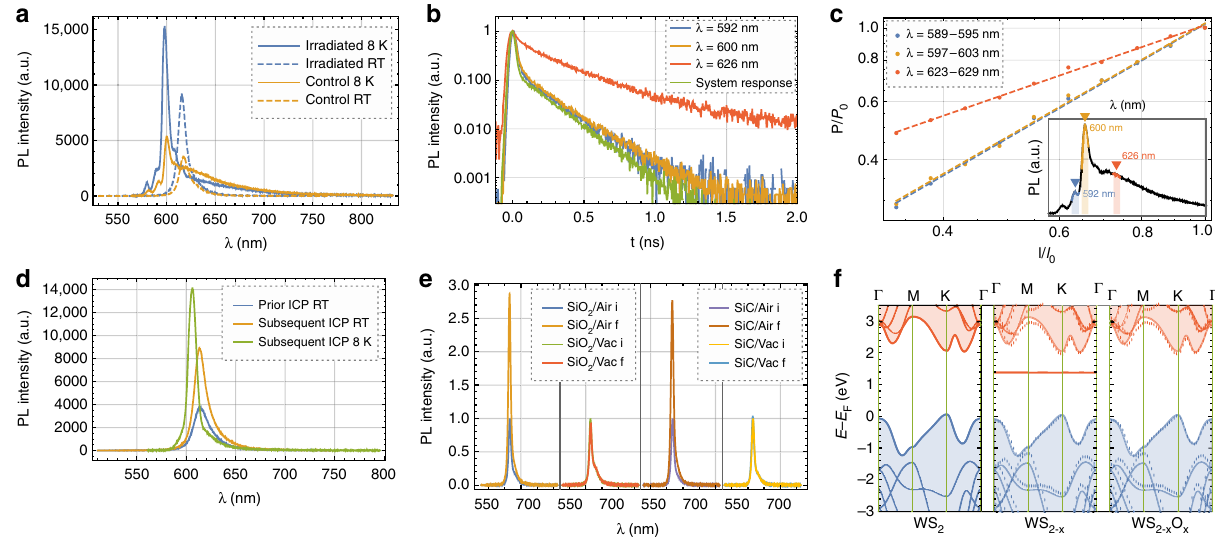
Fig. 5 Identi fi cation of the γ -ray induced healing mechanism. a Photoluminescence (PL) spectrum of γ -irradiated and control samples at 8 K and room temperature. The control sample shows strong defect emission in the red sideband. b Spectrally and time-resolved PL reveals carrier lifetimes close to the system response at λ = 592 and 600 nm and 361(3) ps at 626 nm, con fi rming excitonic and defect nature of the emission. Unlike for defects, the radiative lifetime for excitons/trions is proportional to temperature. The spectral positions at which the lifetimes were measured are marked with correspondingly colored triangles in c (small inset). c Spectrally resolved power dependence on a log-log plot reveals a slope close to 1 at λ = 592 and 600 nm, indicating excitonic emission, while the slope <1 at 626 nm means the emission originates from defects. The inset shows the positions in the spectrum (marked with the corresponding colors) at which the power dependence is measured. d PL emission prior and subsequent to the inductively coupled plasma treatment shows a similar increase in PL brightness compared to the γ -irradiated samples. In addition, at low temperature no defect emission becomes visible, con fi rming that oxygen can passivate vacancies. e Repetition of the γ -irradiation on SiO 2 and SiC substrates as well as in air and vacuum show that the atmosphere must be the source of oxygen used for the defect healing, most likely through adsorbed oxygen onto the surface. f Density functional theory calculations of the bandstructure of pristine WS 2 (left), WS 2 − x (middle), and WS 2 − x O x (right) show that, unlike the V S defect, the S O defect has no unoccupied deep mid-bandgap state. The middle and right bandstructure show the conduction and valence band from the primitive pristine unit cell (solid lines) overlayed with the conduction and valence band from the supercell calculations (dotted